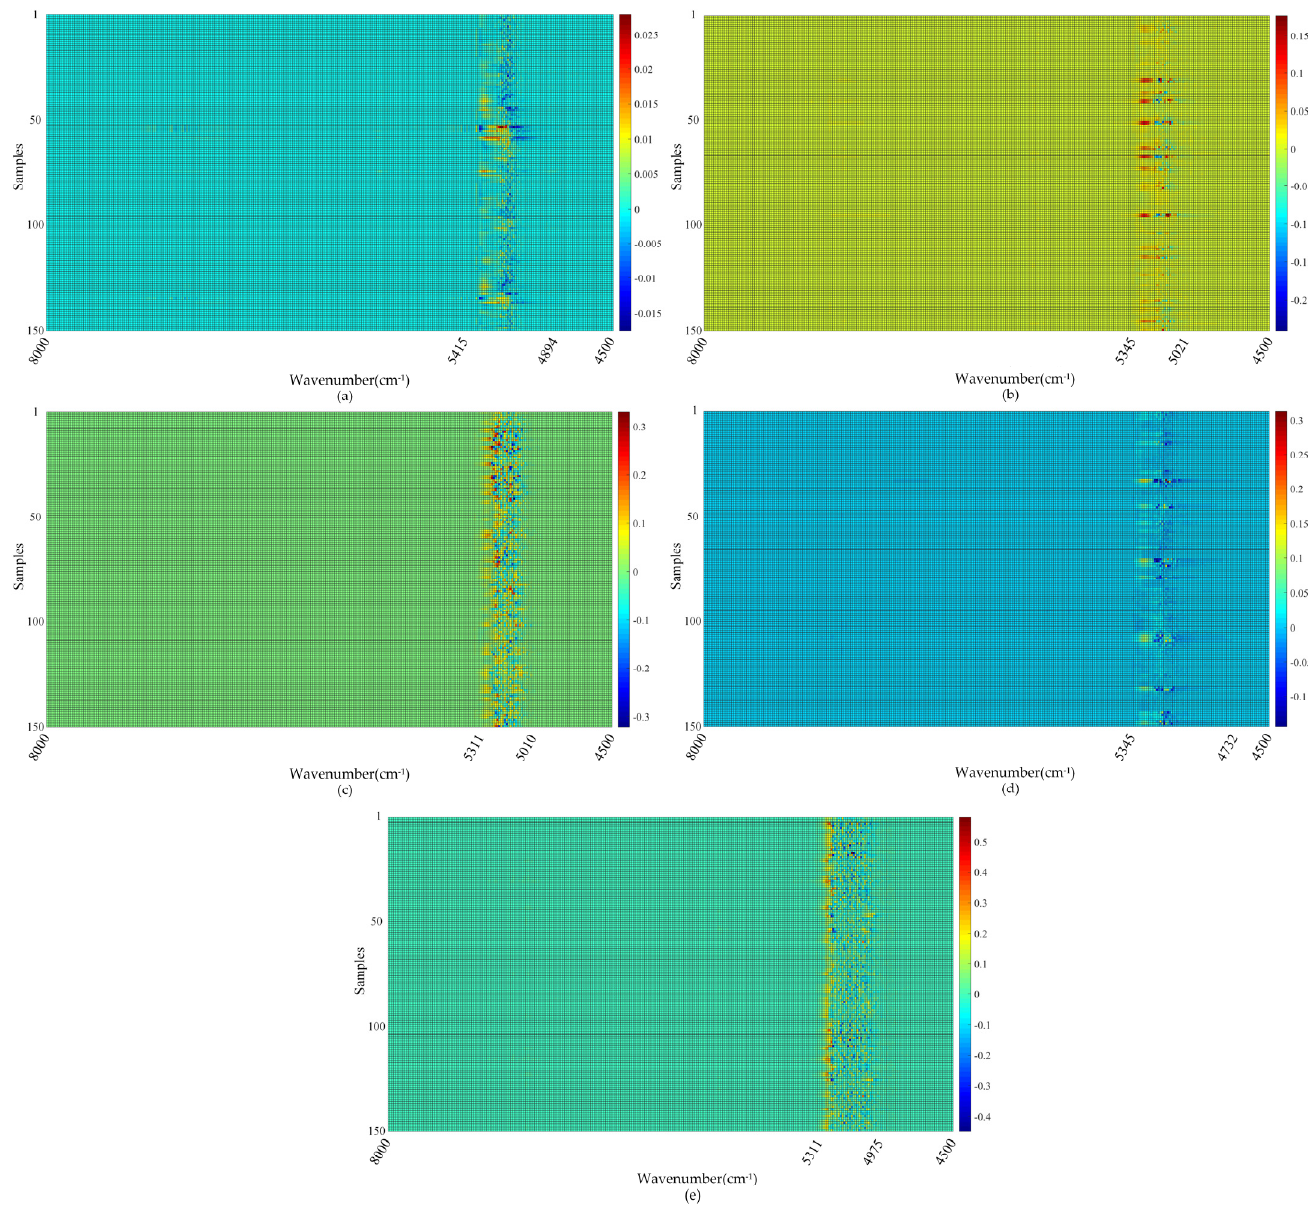
Figure 7. ( a – e ) The heat maps of the sparse matrices of five classes of liquor samples, respectively.